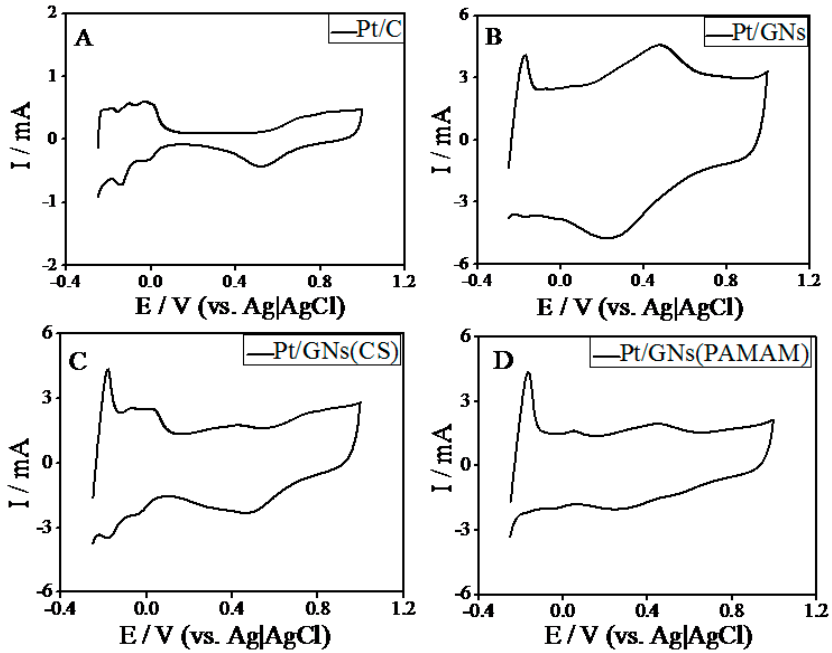
Figure 4. CV curves in 0.5 M H 2 SO 4 at 100 mV ∙ s − 1 : Pt/C ( A ); Pt/GNs ( B ); Pt/GNs (CS) ( C ); Pt/GNs (PAMAM) ( D ).